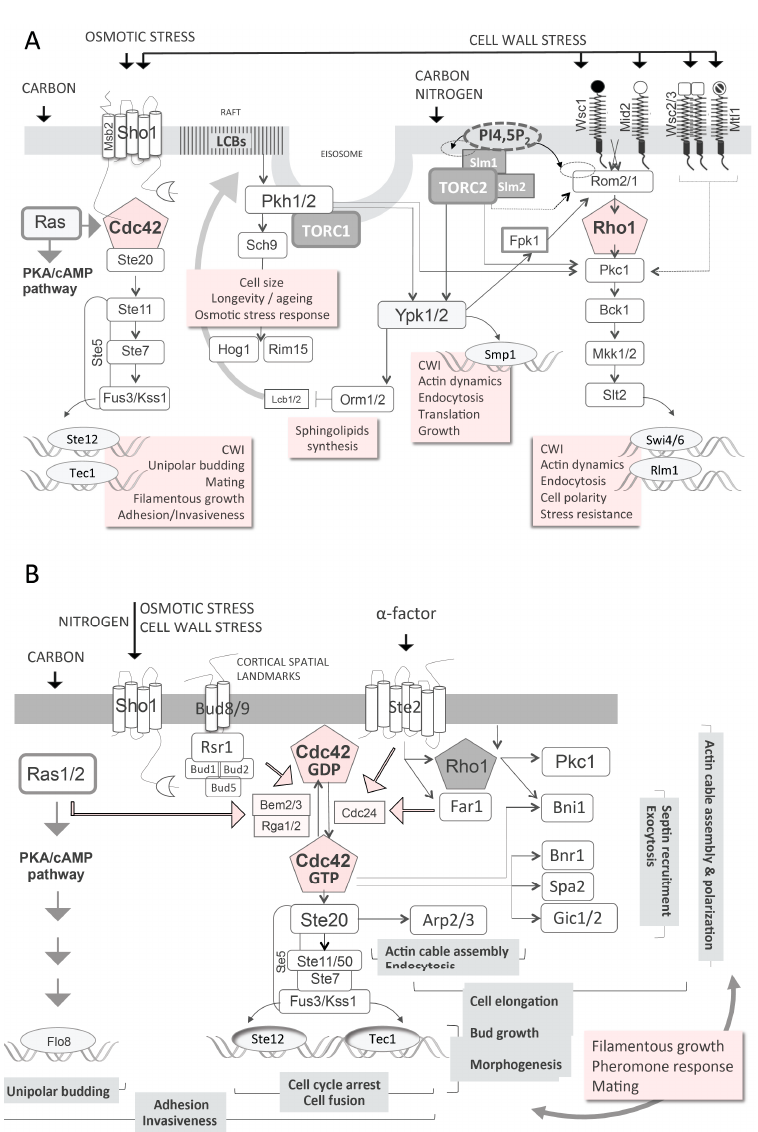
Figure 1. Major players implicated in the phenotypes associated with the deletion of GUP1 in S. cerevisiae and C. albicans (grey boxes). Plain arrows indicate established interactions; dashed arrows indicate possible interactions. Pentagons refer to nodal proteins exerting multiple signalling, affecting positively or negatively many other proteins. ( A ) The Sho1 downward cascade belongs to the HOG (High Osmolarity Glycerol) pathway, and the Rom/Rho cascade constitutes the Cell Wall Integrity—CWI/PKC pathway. Crosstalk between HOG, PKC, the complex lipids and TORC1/2 signalling pathways relevant for GUP1 associated phenotypes is shown; ( B ) Centrality of Cdc42 phosphorylation (pink boxes) in the control of pathways ultimately promoting differentiation, polarity, growth and reproduction. The central role of one protein shared by many pathways is designated in the text as star -type pathway.